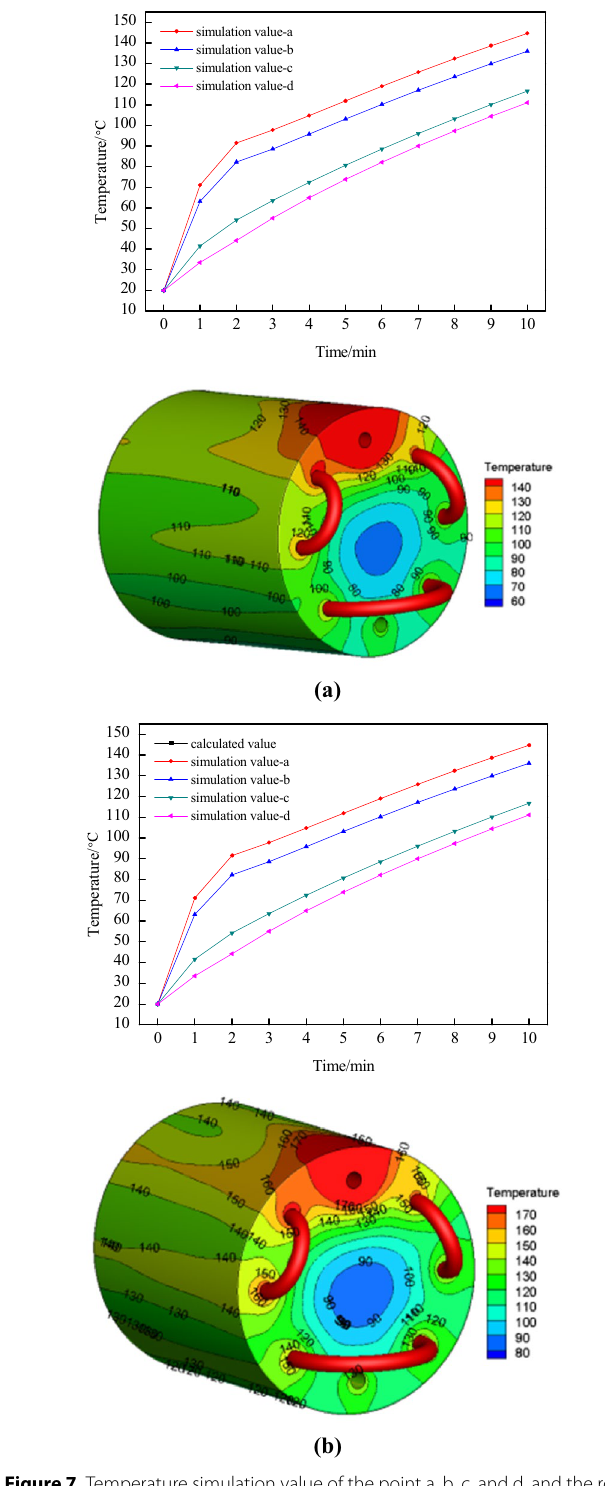
0.3 m/s; b v 0.5 m/s; c = =